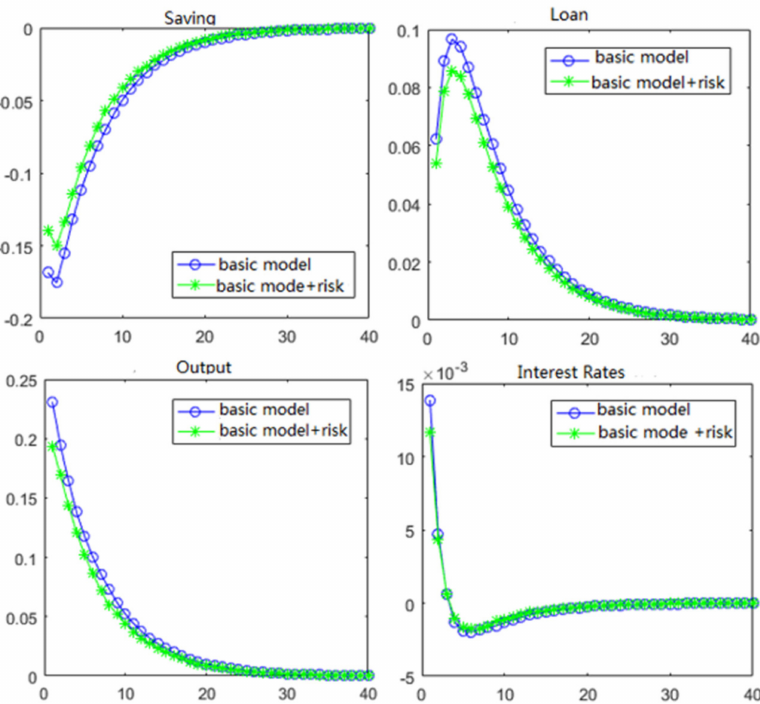
Figure 6. Impulse response results of major variables under price and monetary policy (basic model; extended model).